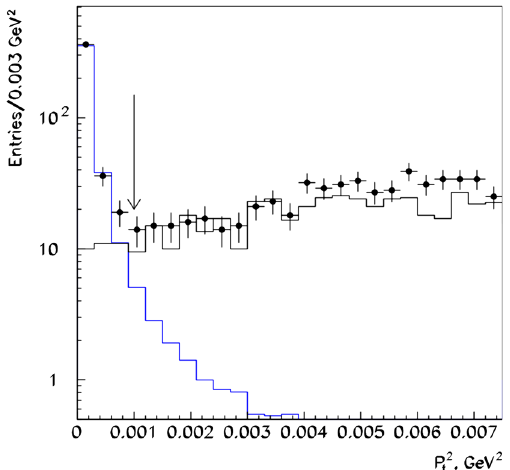
Fig. 2 The distribution of the square of transverse momentum of the 3 πγ system for the data (black circles with errors), main sources of the background (black histogram) and the MC signal (blue histogram). Vertical arrow corresponds to the cut position